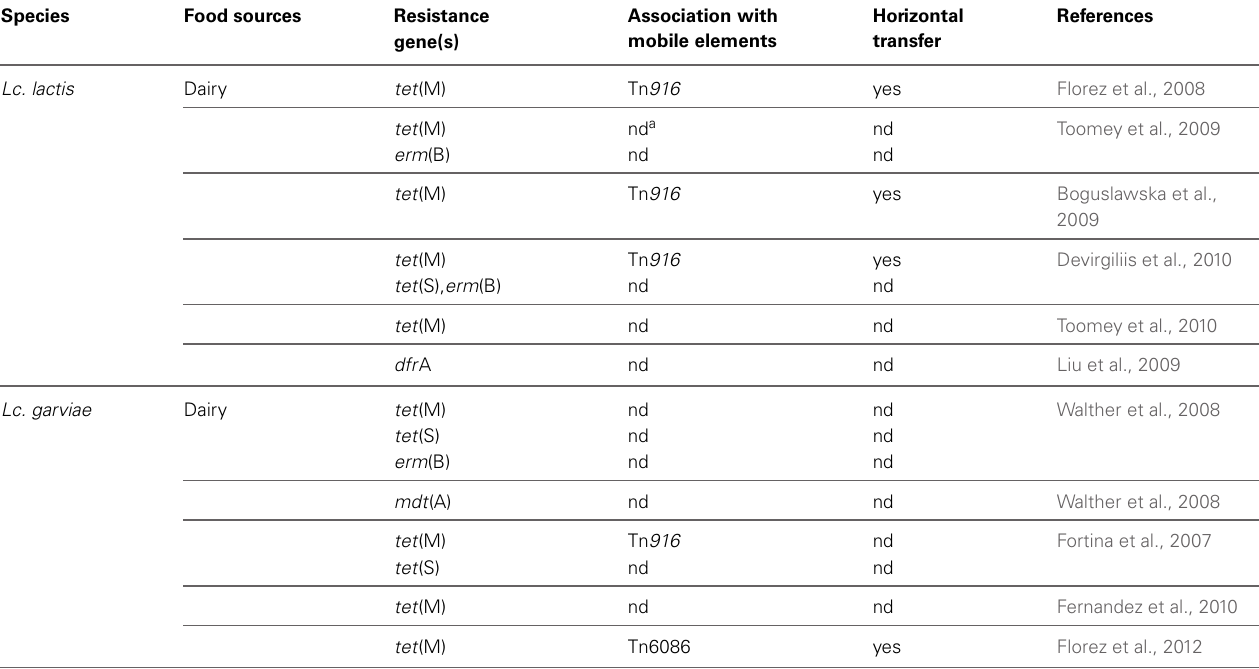
Table 3 | Foodborne Lactococcus species reported to carry AR genes and sources of